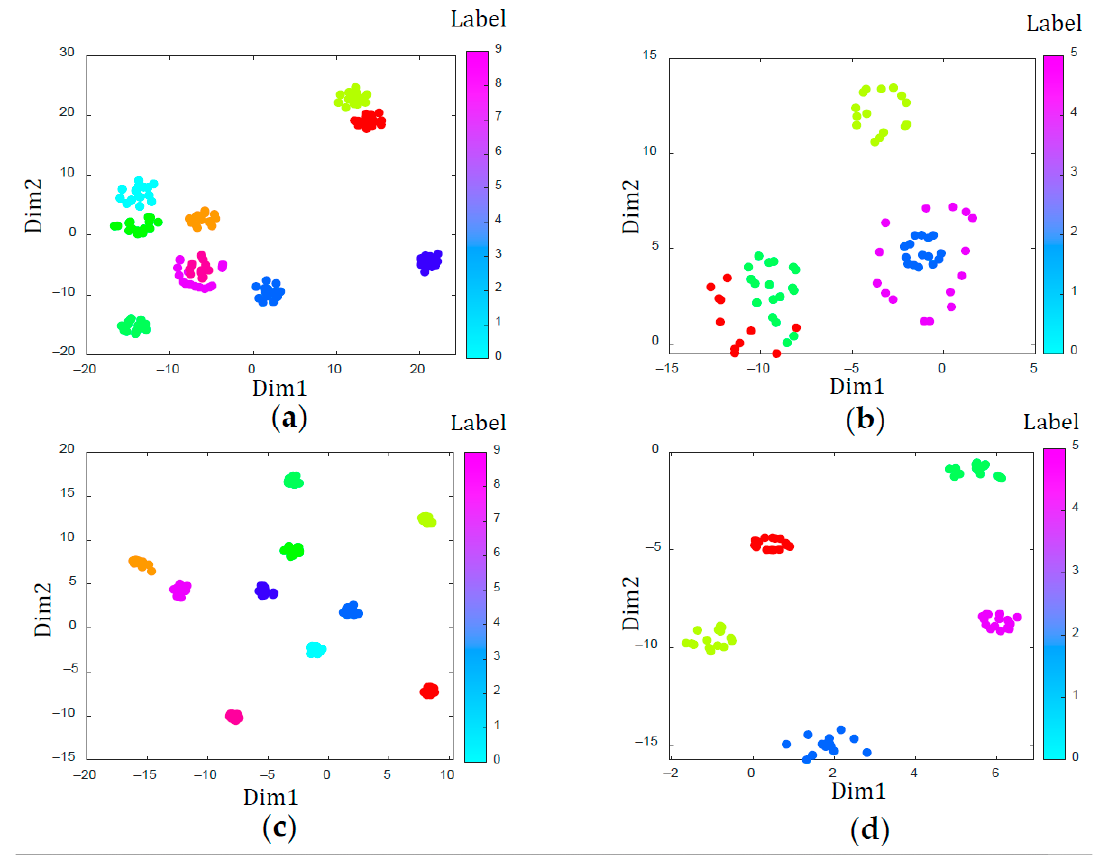
Figure 11. Visualization of the features extracted by Pro net and the wavelet-prototypical network based on fusion of time and frequency domain (WPNF) via t-SNE. ( a ) Pro net on the training set; ( b ) Pro net on the test set; ( c ) WPNF on the training set; ( d ) WPNF on the test set.